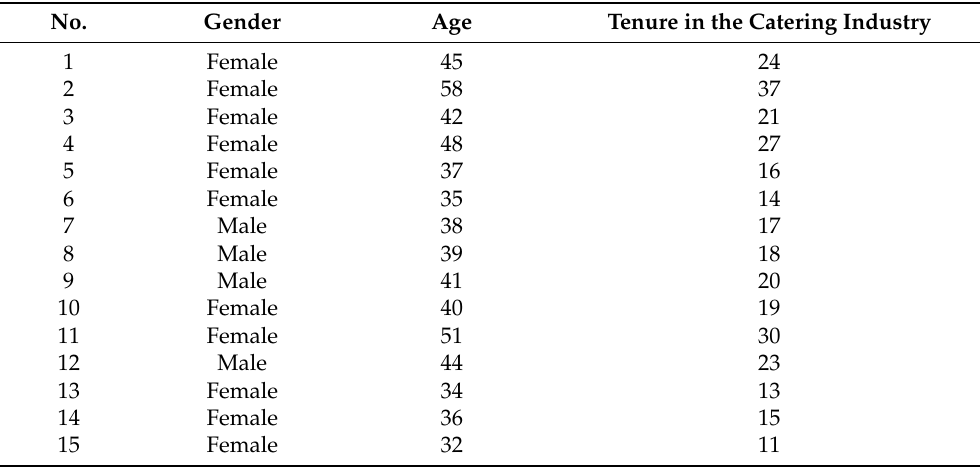
Table 1. Socio-demographic background of restaurant